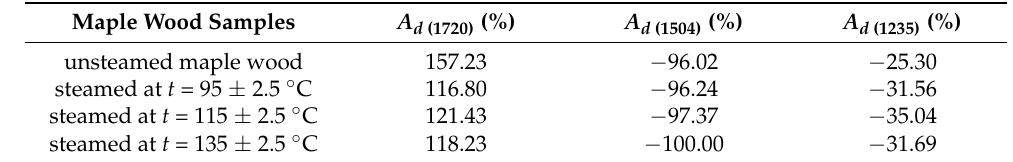
Figure 6. Differential ATR-FTIR spectra expressing the effect of UV radiation on unsteamed and steamed maple wood. Table 3. Values of differential absorbances of selected absorption bands expressing the influence of UV radiation on unsteamed and steamed maple wood.